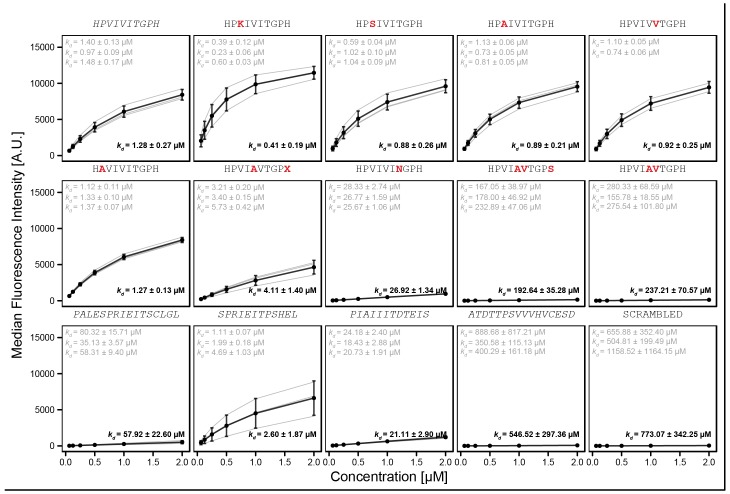
'Triplicate high' library of reported PVIVIT and natural variants.Amino acid letter in red text indicate the mutation from WT sequence (grey). Each peptide was synthesized separately onto three different codes (with the exception of HPVIVVTGPH with only two codes). Binding curves were fit with a Langmuir isotherm model to estimate binding affinity Kd.